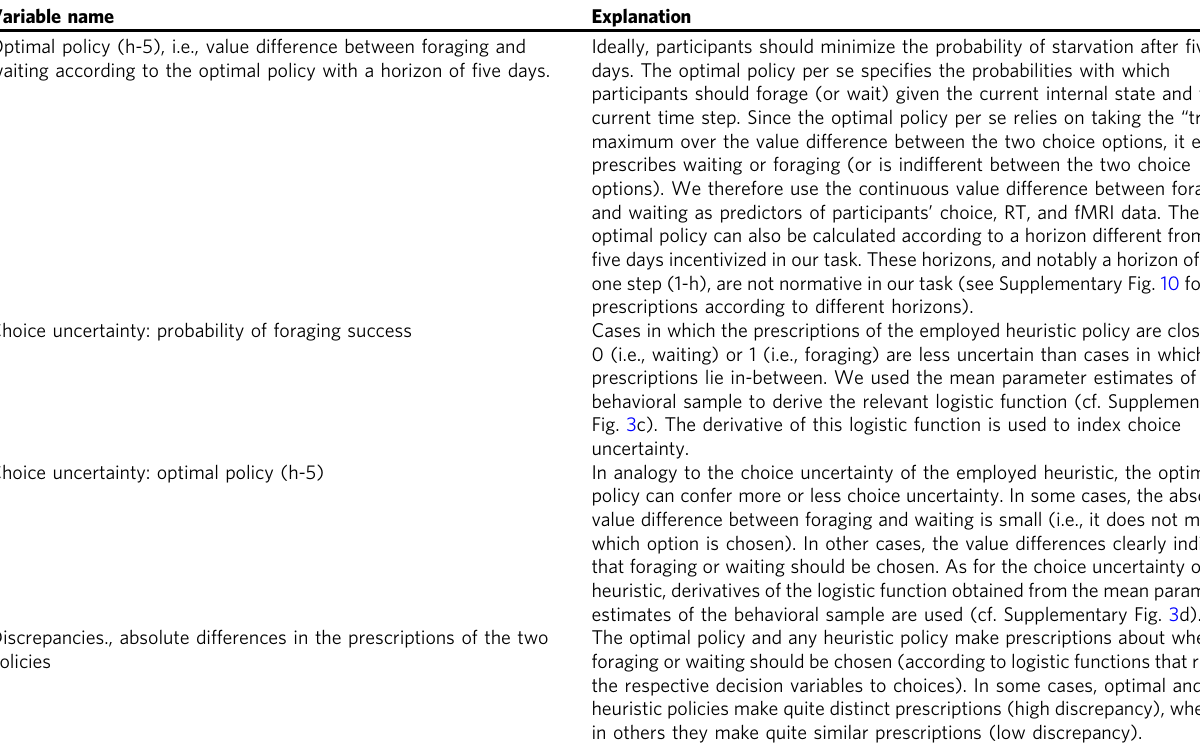
Table 2 Overview of variables related to the optimal policy, choice uncertainties, and discrepancy Variable